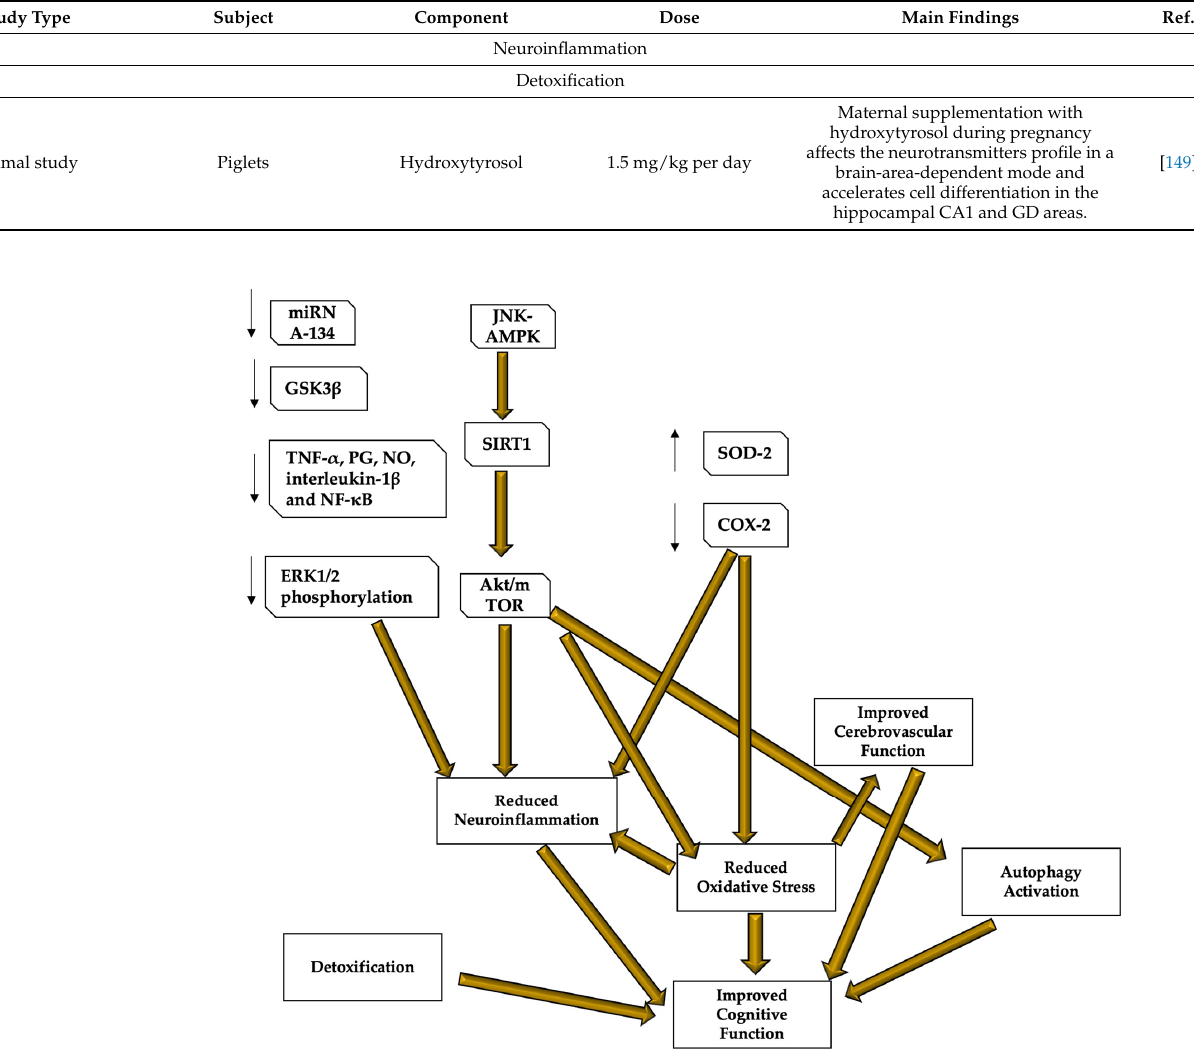
Figure 3. Resveratrol and hydroxytyrosol molecular mechanisms of action. Resveratrol and